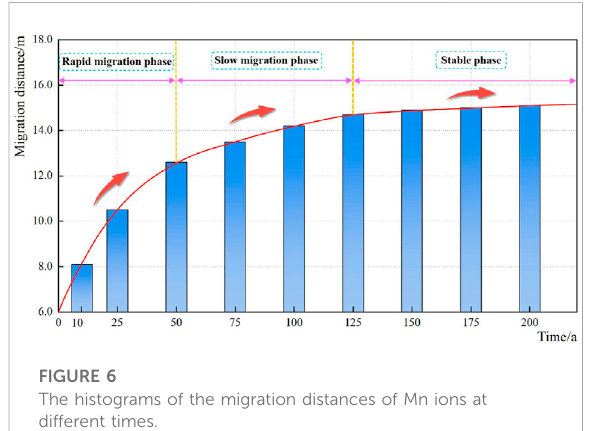
FIGURE 7 The environment where the gangue back fi ll body is